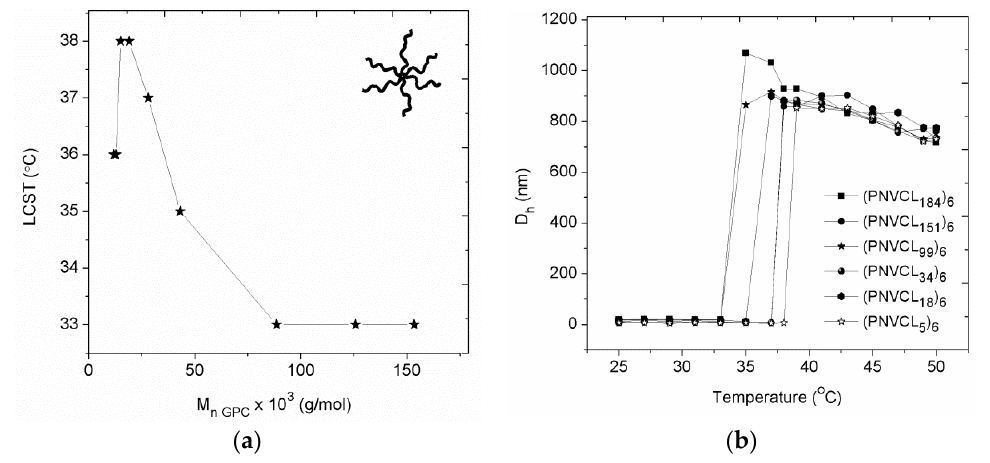
Figure 2. Dynamic light scattering (DLS) measurements ( c = 1 mg/mL in water): ( a ) effects of molecular weight on the lower critical solution temperature (LCST) of star (PNVCL) 6 polymers; and ( b ) evolution of the D h of the (PNVCL) 6 polymers as a function of the temperature.